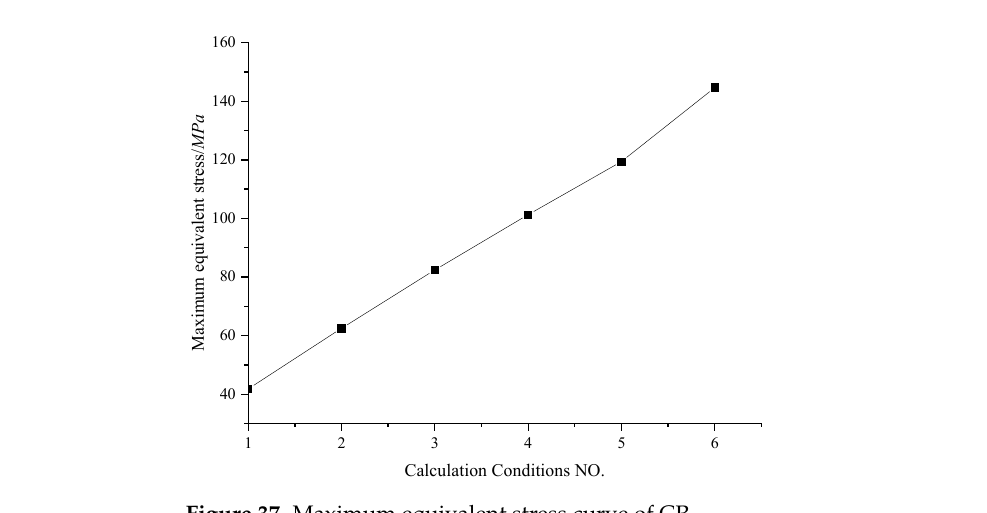
Figure 37. Maximum equivalent stress curve of CR. Nephograms of tie-down forces under each calculation condition are shown in Figure 38, which indicate that the tie-down force at the short axis is largest, followed by the long axis, and the cable force at the quarter is relatively the smallest. When the pull-down is completed, the cable force of the tie-downs reaches a maximum value of 547.6 kN.